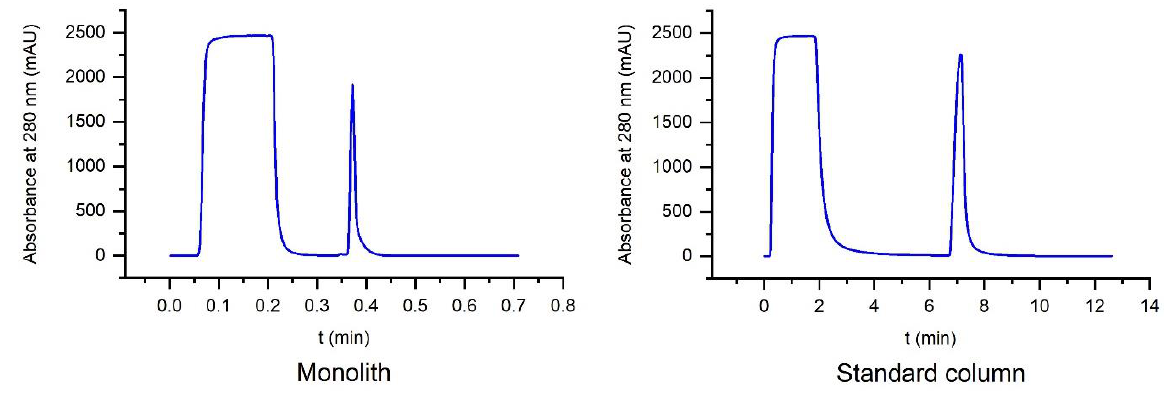
Figure 10. Comparison of a standard Sephadex-based system with the glass monolith. Please note the very different time scales of the separations. The standard column had a total volume of 1 mL, the monolith around 0.75 mL.